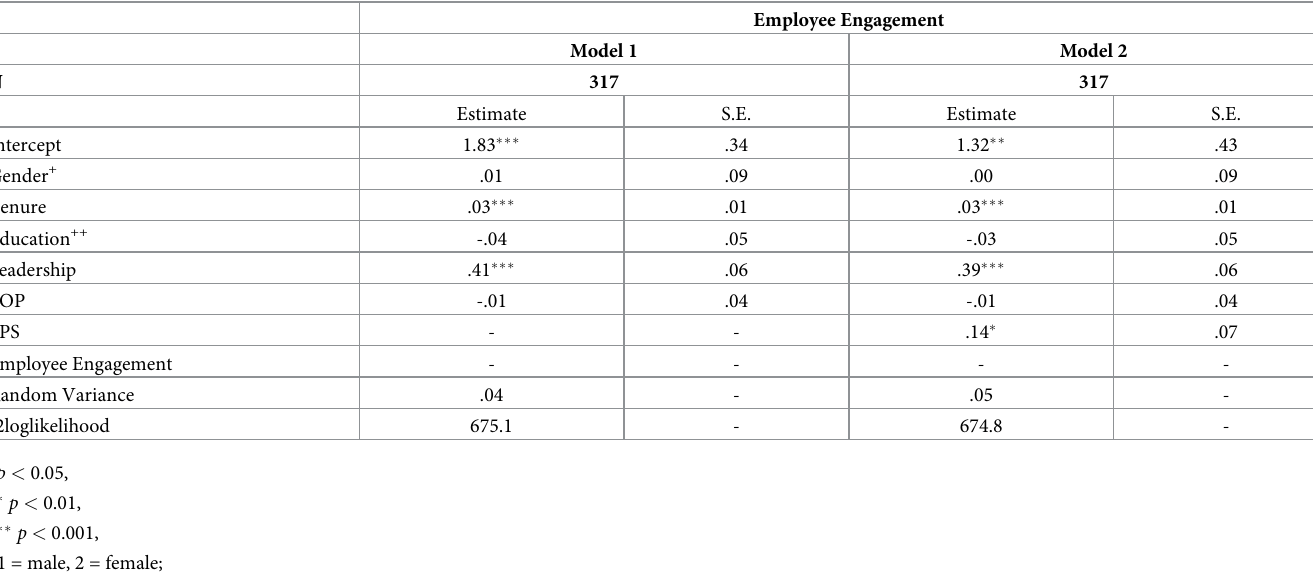
Table 6. Multi-level analysis with employee engagement as dependent